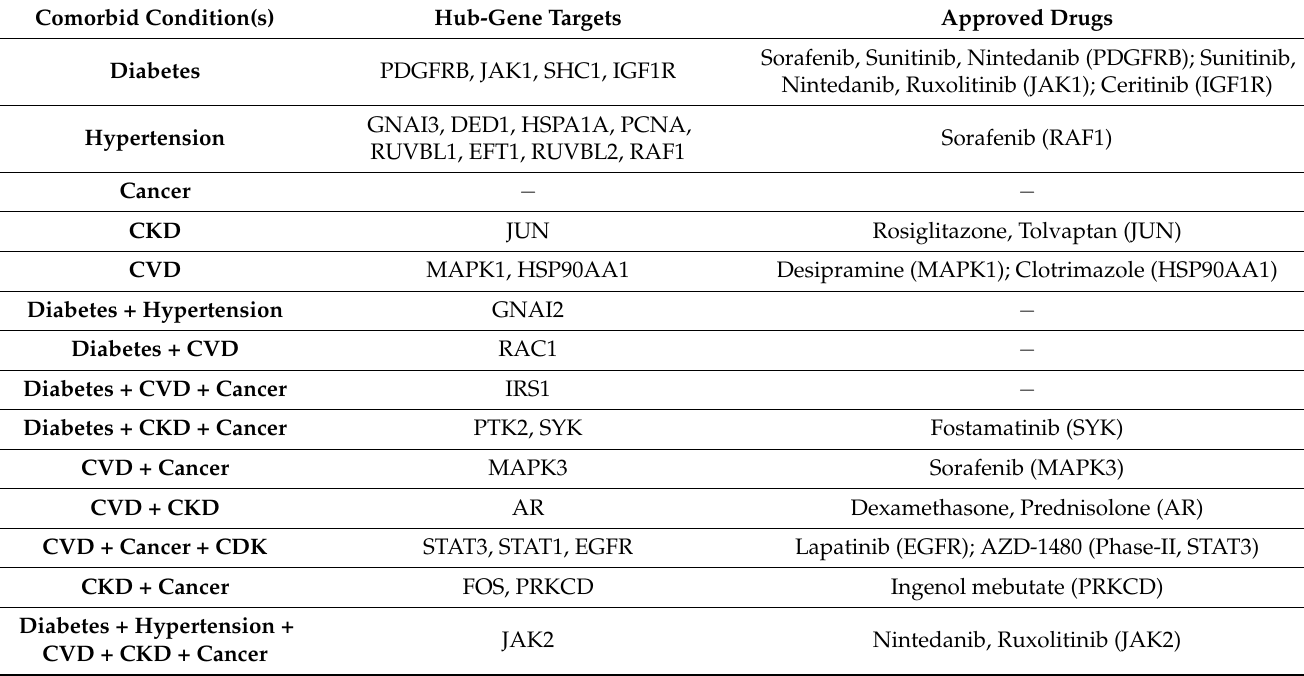
Table 3. Hub-gene targets and drugs for individual and combinations of comorbidities in COVID-19. Other drugs for these targets are presented in Figure